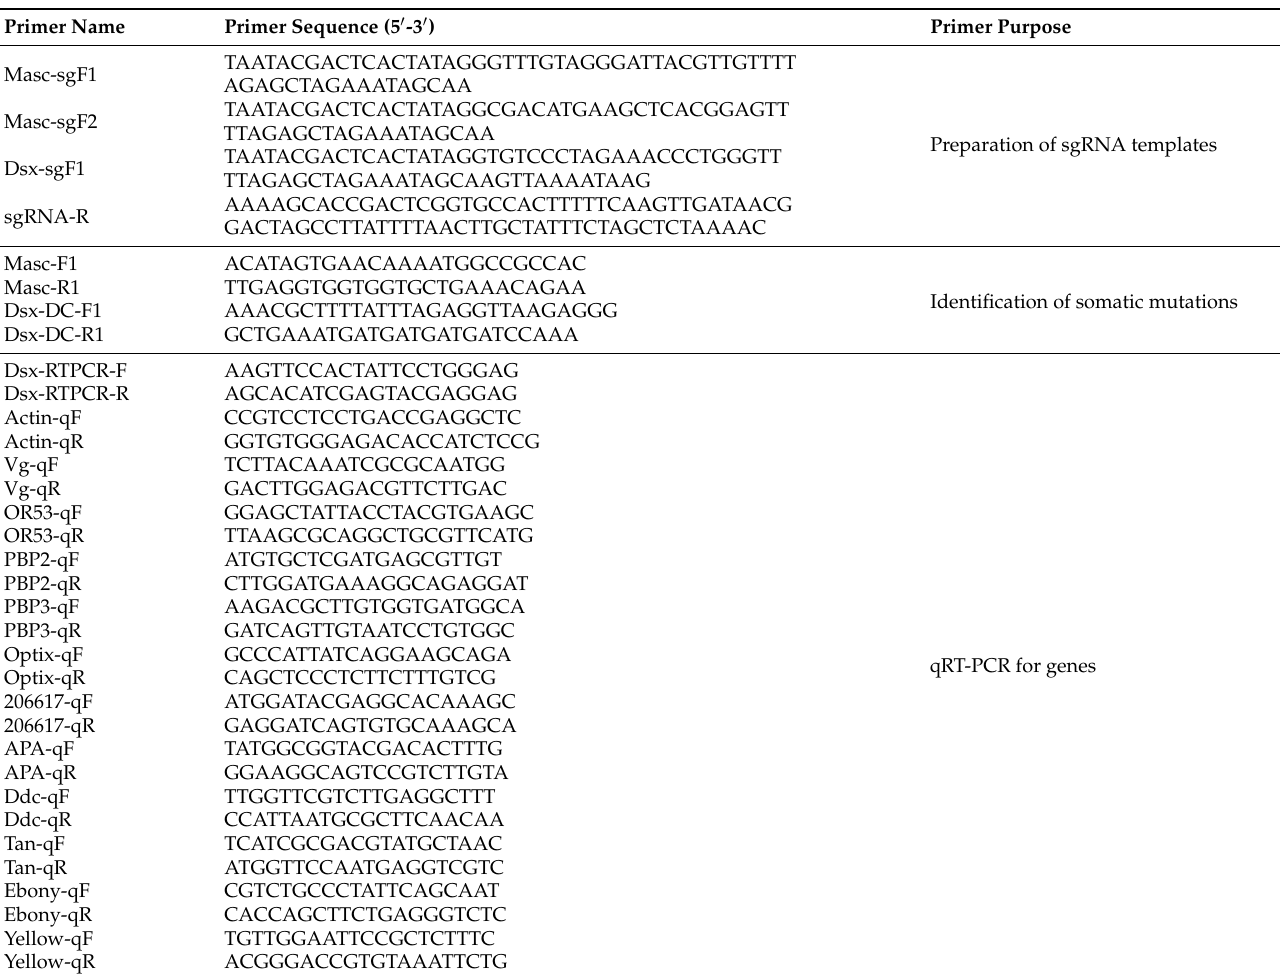
Table 2. Primers used in PCR amplification and mutant